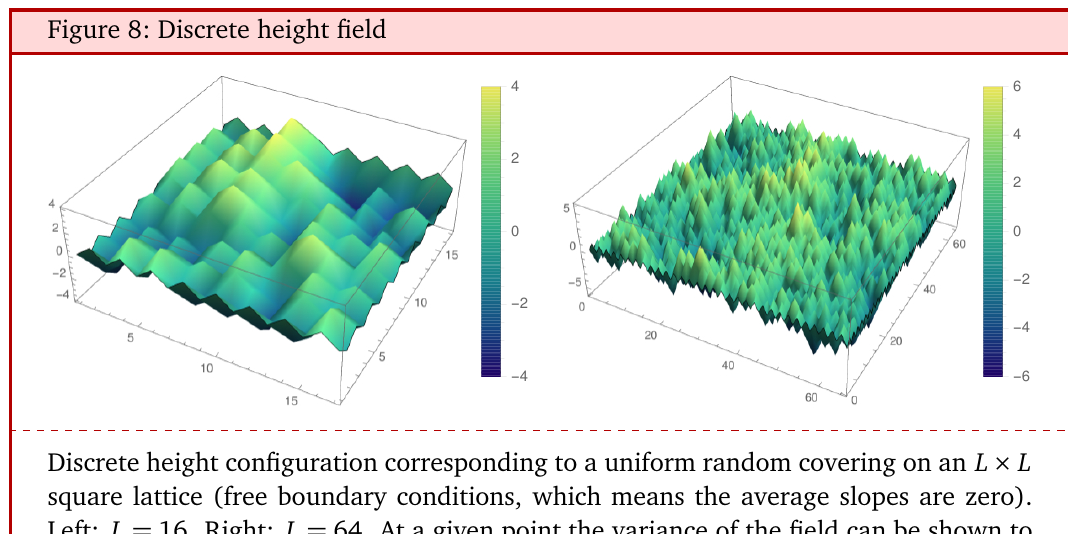
Figure 8: Discrete height